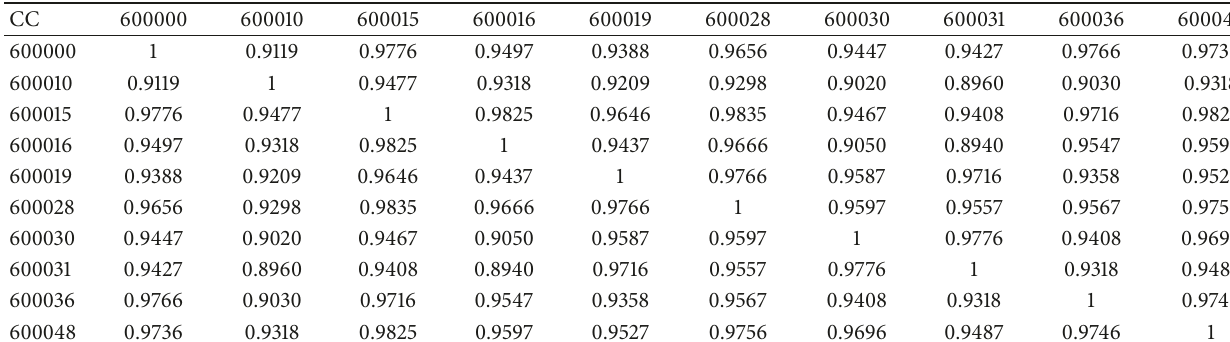
Table 7: Prediction correlation matrix.